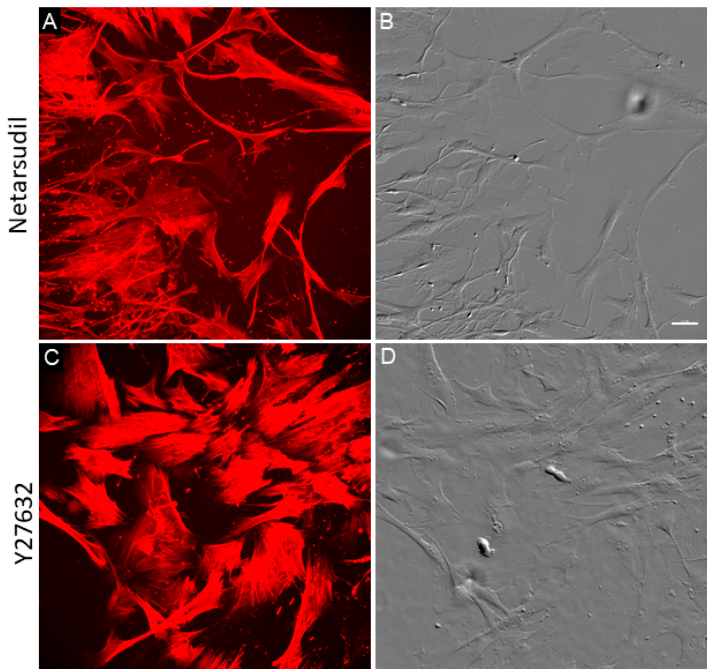
Figure 2. Prolonged effects of netarsudil on glaucomatous TM cells. GTM cells were treated for 3 h with 1 µ M netarsudil ( A , B ), or 1 µ M Y27632 ( C , D ), washed and incubated for a further 48 h in fresh medium. Fixed cells were imaged by a laser confocal microscope. Red = SiR-actin; grey = phase gradient contrast. Scale bar = 50 µm.